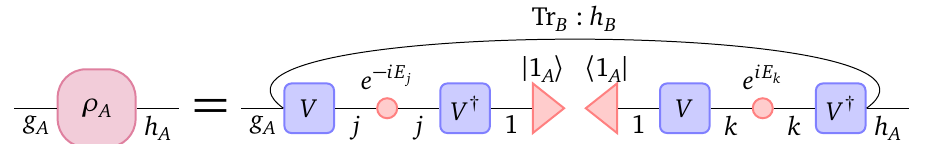
Figure 1: Diagram of expression (5). Lines indicate matrix multiplication, with summed index below. The outer indices are split into a subsystem and bath double-index, the trace sums over the